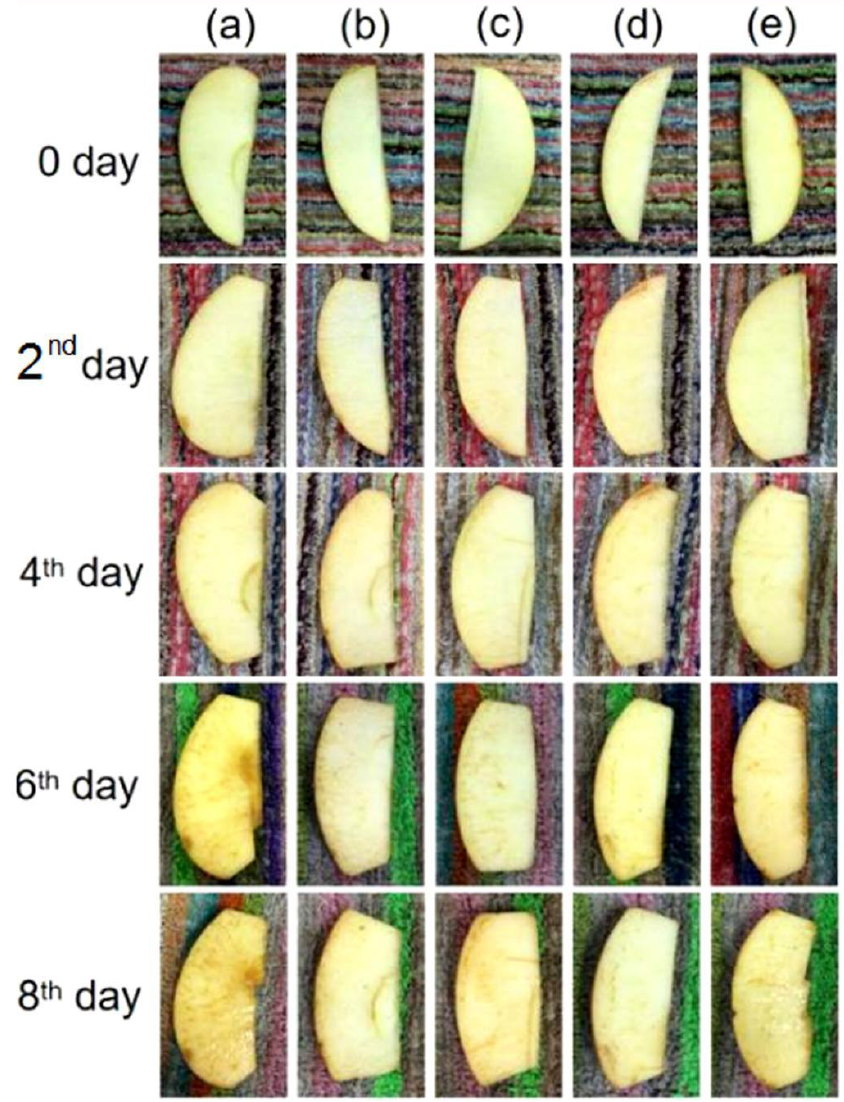
Figure 14. Ancillary packaging of apple slices and their appearance: ( a ) No fiber packaging; ( b ) F4 packaged group; ( c ) F5 packaged group; ( d ) F6 packaged group; ( e ) F7 packaged group.